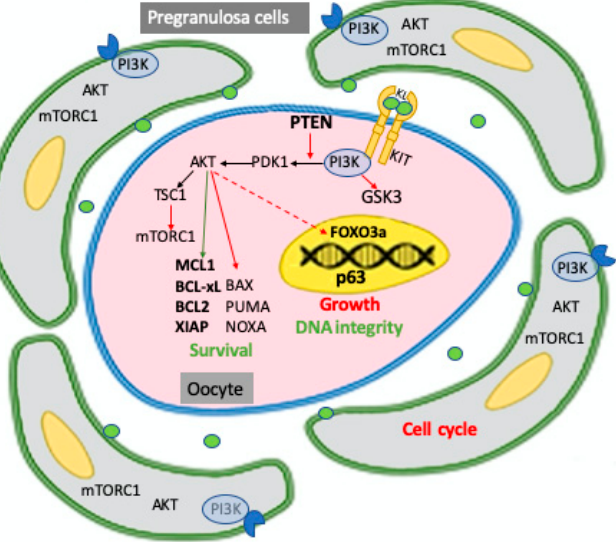
Figure 3. Schematic representation of PI3K/PTEN/AKT signaling pathways identified, mainly in the mouse, in the two components of the primordial follicle, pregranulosa cells, and oocyte, and of their major targets involved in maintaining the dormancy of the follicle including cell cycle in pregranulosa cells and survival, growth, and DNA integrity in the oocyte. As extensively discussed in the test, pregranulosa cells are arrested in the reversible GO cell cycle stage while the oocyte within the primordial follicle is maintained in a quiescent status, requiring the prevalence of survival upon proapoptotic factors, preservation of DNA integrity, and the inhibition of transcription necessary to its growth. In oocytes, all or a relevant part of these activities require the basal level of PI3K/AKT activity finely regulated by the KL/KIT system and PTEN. Activation or inhibition of AKT on its substrates are represented as green and red arrows, respectively; the inhibitory action of AKT on FOXO3a is represented with a dotted arrow since it is exerted only after oocyte activation. According to a current model, not illustrated in the figure, but reported in the test, signals from the microenvironment able to activate the PI3K/AKT/mTORC1 pathways in the pregranulosa cells reverse GO to the G1 stage and increment the production and release of factors, among these KL, which also incremented the PI3K/AKT/mTORC1 activity in the oocyte, leading to increased protein synthesis and removing the FOXO3a inhibition on its growth; in turn, the growing oocyte releases factors such as BMP15 and GDF9, which stimulate pregranulosa cell proliferation and their maturation into granulosa cells. Follicular activation also requires inactivation and removal from the oocyte nucleus of the transcription factor FOXO3a and the cyclin dependent kinase (CDK) inhibitor 1B (commonly known as p27kip1 or p27); this latter is also inactivated in pre-granulosa cells [64,65]. FOXO3a is a substrate of AKT, and is known as a transcription factor that leads to apoptosis and cell cycle arrest in many cell types. As a matter of fact, FOXO3a phosphorylated by AKT is excluded from the oocyte nucleus and is suppressed from functioning as a transcription factor, preventing its growth. Remarkably, overexpression of constitutively active FOXO3 in the nucleus of mouse oocytes preserves them in a dormant state [66]. FOXO3a inactivation by AKT could also have consequences for oocyte apoptosis and capability to repair DNA damage and counteract reactive oxygen species (ROS) effects that FOXO3a usually promotes (see below and [67–69]). In this regard, it has been recently reported that signaling by SIRT1, a NAD-dependent deacetylase that removes acetyl groups from various proteins including histones, acts through FOXO3a-MnSOD to protect